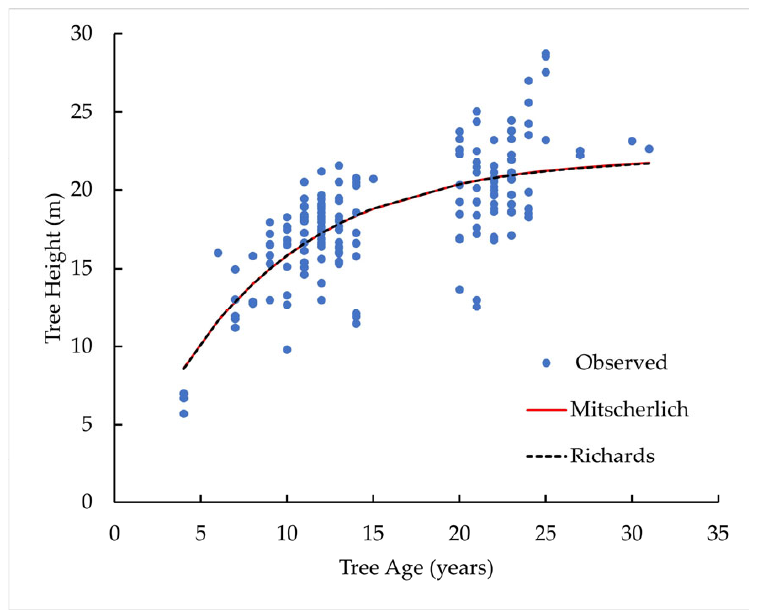
Figure 2. Relationship between tree height and age for 183 sample trees from 61 teak plantations (three trees per plot) located along the transect line. The solid line (Mitscherlich) and dashed line (Richards) indicate the tree height–age curve plotted according to the Mitscherlich (Equation (1)) and Richards (Equation (2)) growth functions (cid:1)(cid:3)